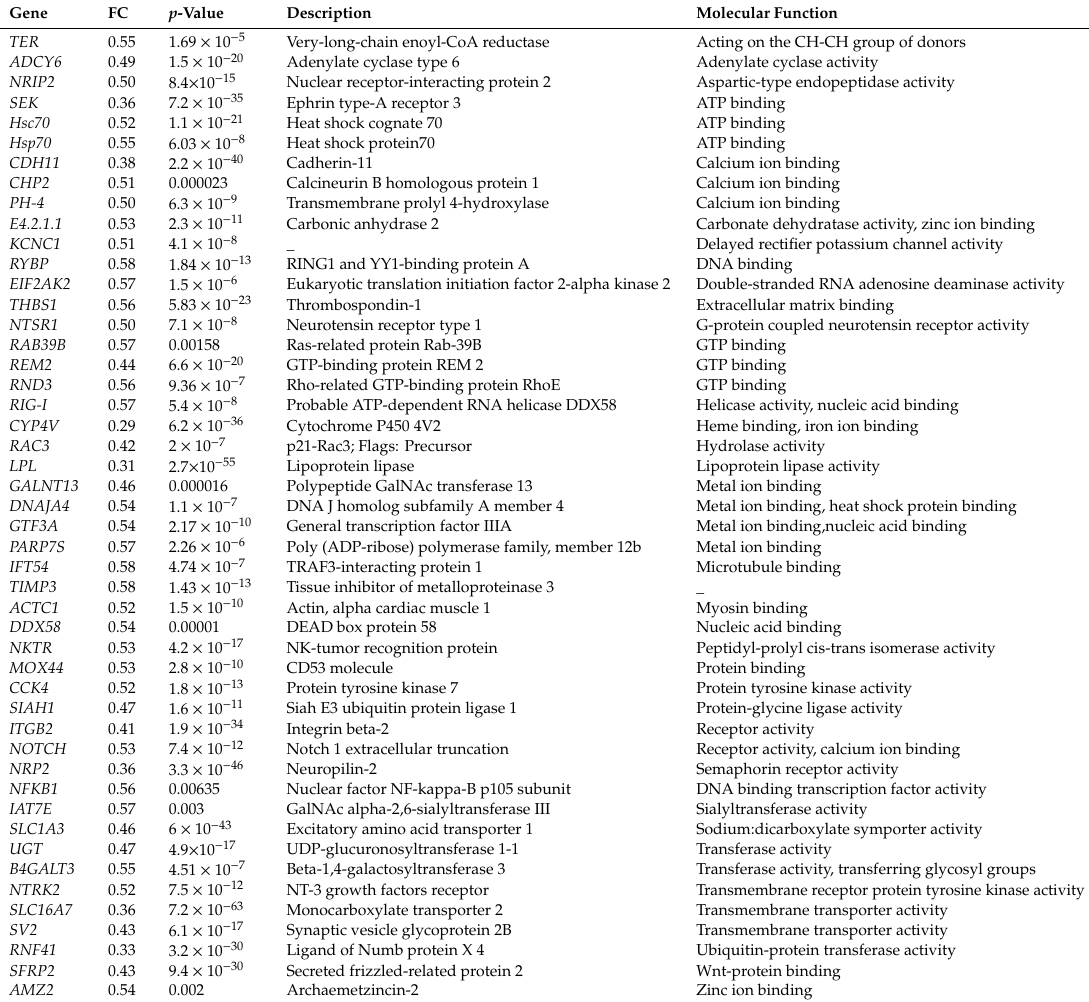
Table 2. Down-regulated genes by EGF in grass carp pituitary